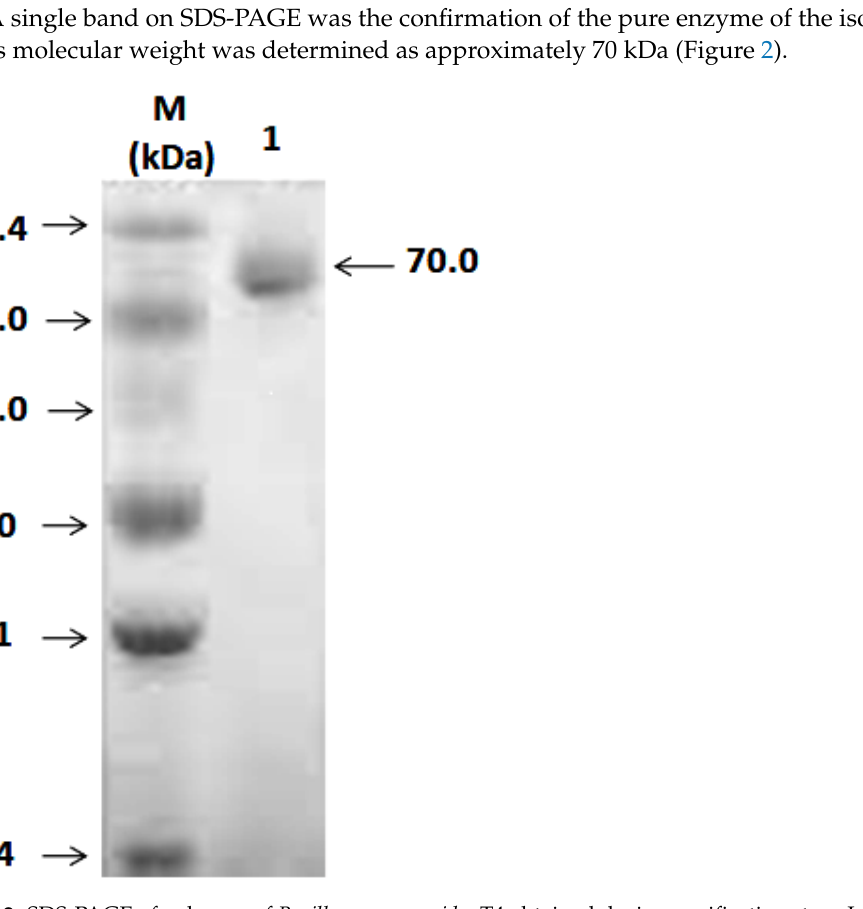
Figure 2. SDS-PAGE of xylanase of Bacillus paramycoides T4 obtained during purification steps.Lane 1: marker proteins; lane 2: purified enzyme obtained after gel-filtration chromatography. Molecular weights were presented in the form of kDa.